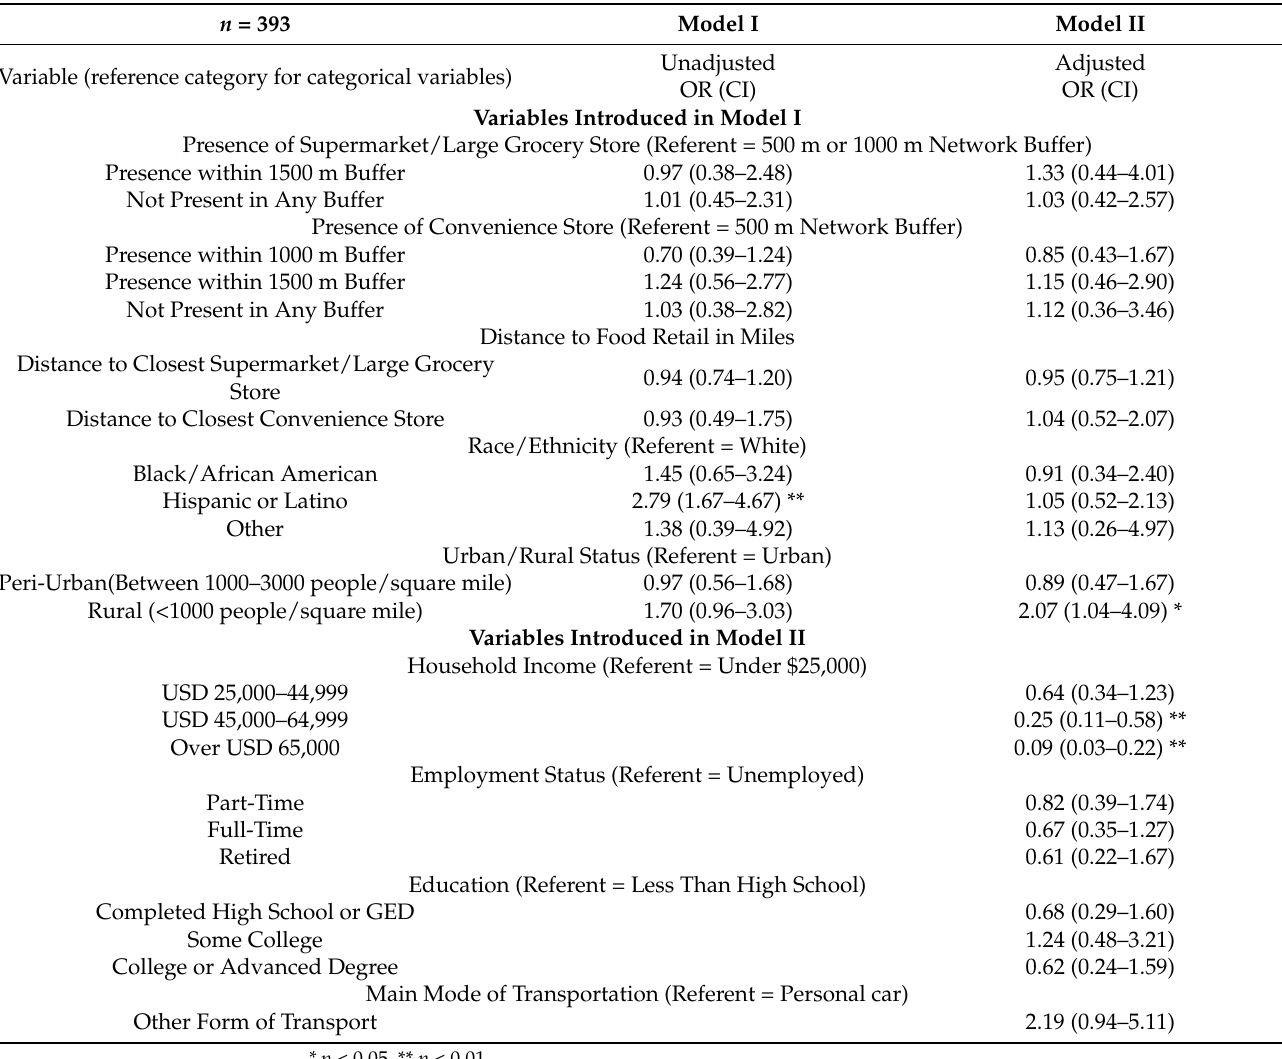
Table 2. Logistic regression examining the association between geographic food access, food insecu- rity status, and various indicators and potential